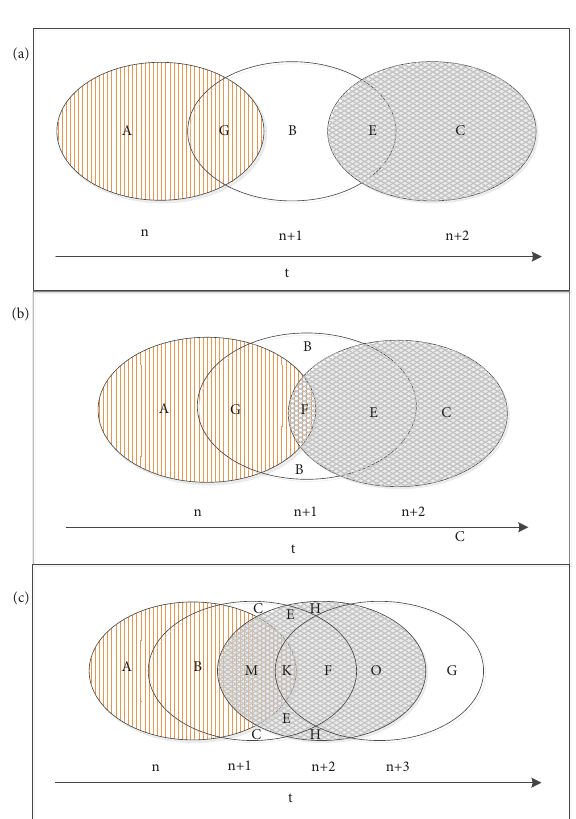
Figure 2: Evolution of delay flights with